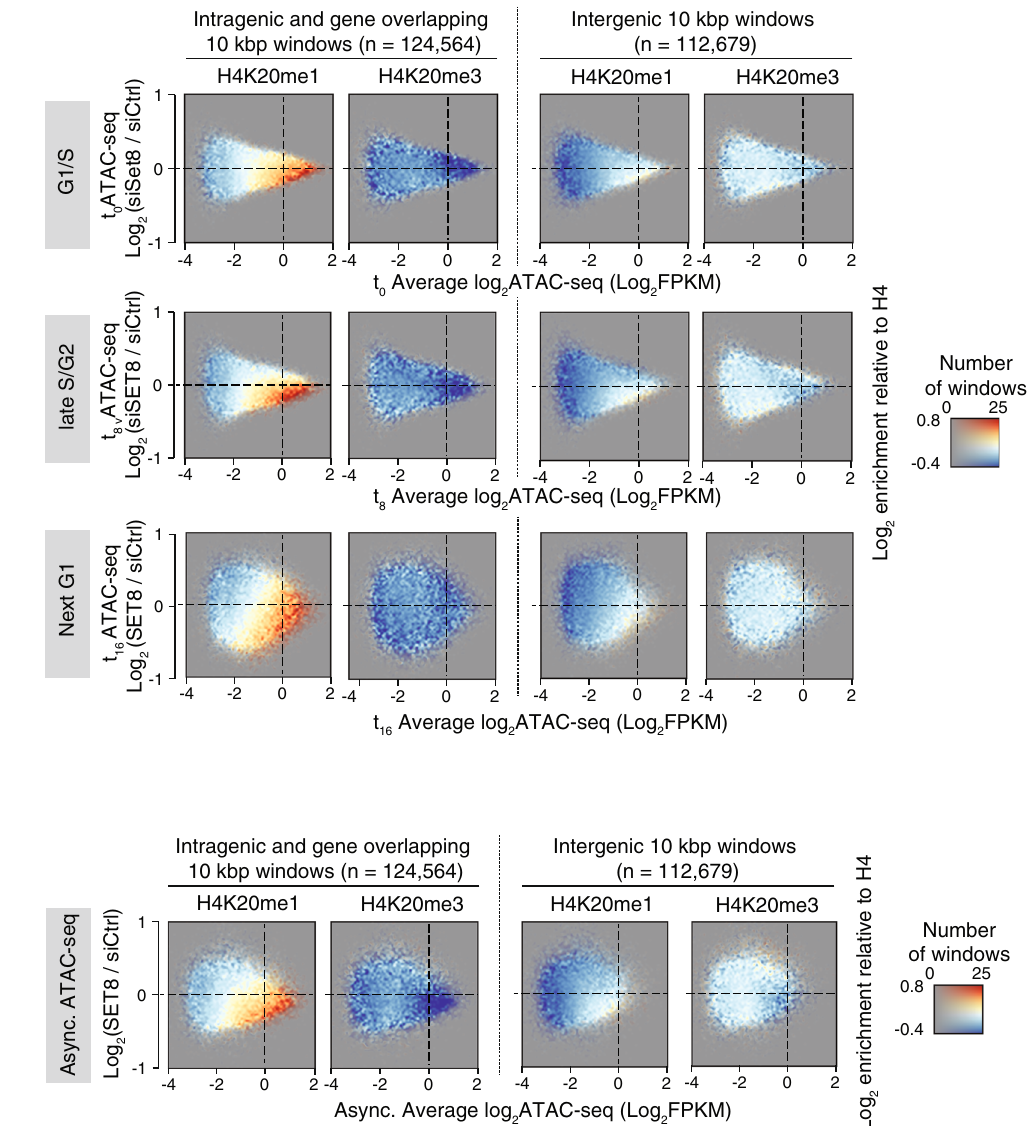
Fig. 2 SET8 ensures chromatin accessibility at genes bodies throughout the cell cycle. a , b Colored 2D-histograms showing the genome-wide three-way relationship between enrichment of H4K20me1 (color) and the level of ATAC-seq signal in SET8-knockdown (kd) over control-kd in U2OS cells. ChIP-seq and ATAC-seq signal was measured in 10 kbp windows and shown separately for windows overlapping fully or partially with annotated gene bodies (leftmost plots) and the windows that did not overlap (rightmost plots). ATAC-seq signal is plotted as MA-plots with average log2 signal from the two conditions on the X -axis and the log2 difference between SET8-kd and control-kd on the Y -axis. Coloring shows log2 normalized H4K20me1 or H4K20me3 ChIP-seq levels relative to the levels of H4 control ChIP-seq as indicated with the number of windows with a certain combination of ATAC-seq levels ( X - axis) and change ( Y -axis) controlling opacity as indicated in the right side color scale. Plots shows FPKM-normalized ATAC-seq signal from cells collected at different cell cycle phases as follows: ( a ) U2OS cells synchronized at G1/S (0 h — top, three replicates), S-G2 (8 h — middle, three replicates) and next G1 phase (16 h — bottom, four replicates), or ( b ) U2OS cells grown asynchronously (four (Supplementary Fig. 6b). Based on our fi ndings in Fig. 2, we then H4K20me1 enrichment, chromatin accessibility changes at predicted that gene expression of H4K20me1 enriched genes is intergenic loci, and the expression changes of the nearest gene SET8 dependent and linked with the ability of the H4K20me1 (Supplementary Fig. 6c, left panel and Supplementary Fig. 6d). In mark to facilitate an open and accessible chromatin state. Indeed, contrast to H4K20me1, H4K20me3 enriched loci did not show after SET8-kd, the expression of H4K20me1-positive genes was this relationship between gene expression and chromatin acces- signi fi cantly reduced (Fig. 3b, left panel). Notably, the loci that sibility (Fig. 3b, right panel and Supplementary Fig. 6c, right displayed loss of expression after SET8-kd and showed the most panel). From these fi ndings, we conclude that SET8-dependent pronounced loss in accessibility had the highest average H4K20me1 enrichment at active genes promotes an accessible H4K20me1 enrichment (Fig. 3c, bottom-left quadrant). As chromatin state, which in turn is permissive for gene expression. expected, there was no observable relationship between Furthermore, H4K20me1-dependent chromatin accessibility at